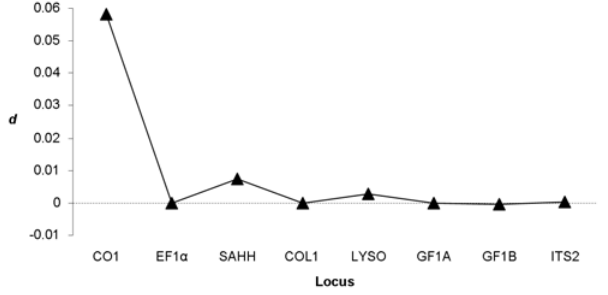
Figure 4. Difference in sequence divergence between B. azoricus and B.puteoserpentis . Each point represent the value of absolute divergence d for the locus shown on the x-axis: d = d azo/puteo 2 ( p puteo + p azo )/2 where d azo/puteo is the mean interspecific sequence divergence between B. azoricus and B. puteoserpentis , and ( p puteo + p azo )/ 2 is the mean population diversity between B. azoricus and B. puteoserpentis . Under a strict isolation model consistent with the traditional phylogeny (strict divergence azoricus/puteoserpentis ), the value of d is expected to be greater from zero for most loci. doi:10.1371/journal.pone.0006485.g004 PLoS ONE |